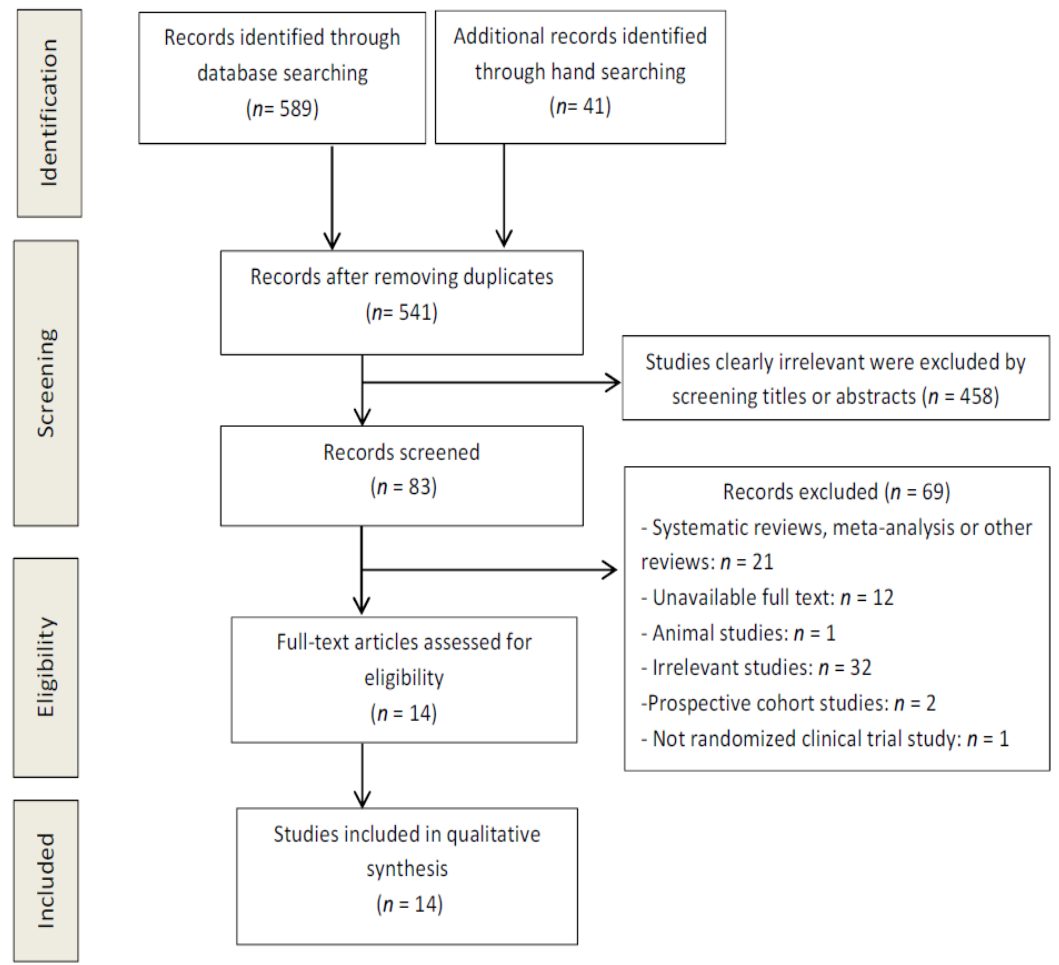
Figure 1. Preferred Reporting Items for Systematic Reviews and Meta-Analyses (PRISMA) 2009 flow diagram.